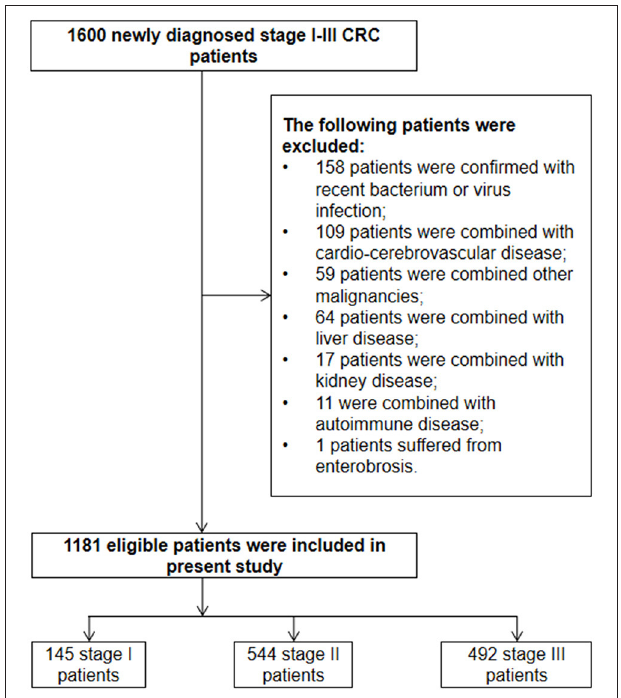
FIGURE 1 | The detailed enrolled procedure of eligible patients in our study.